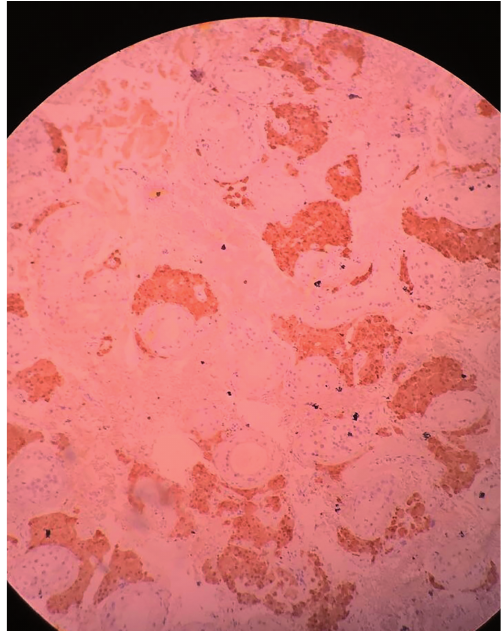
Figure 2 - Seminiferous tubules